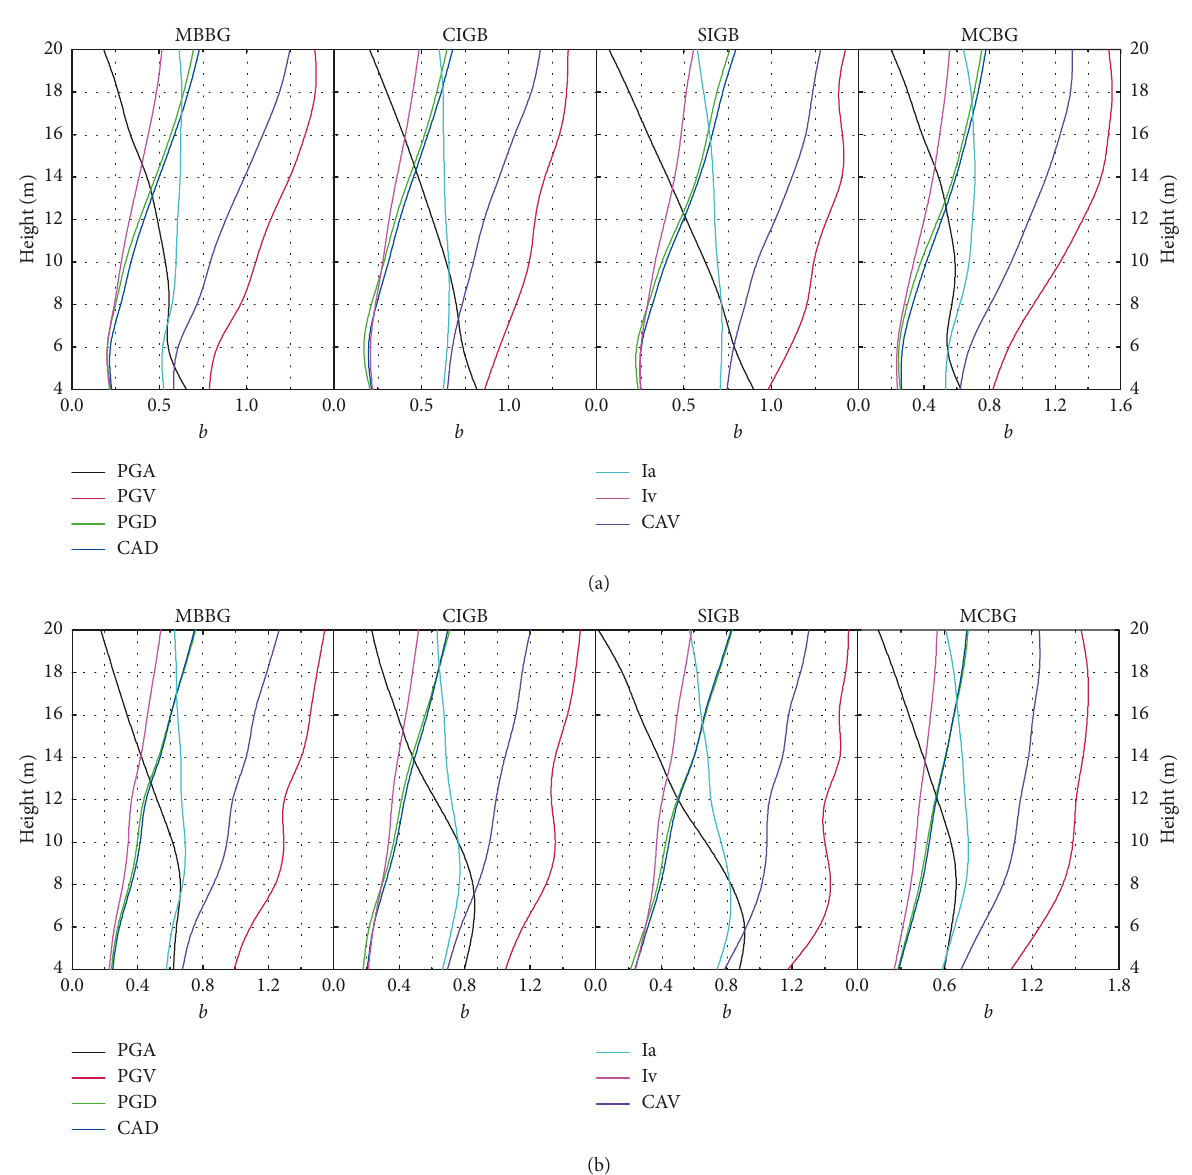
Figure 8: IMs practicality comparison for (a) the pier curvature ductility along the longitudinal direction and (b) the pier curvature ductility along the transverse